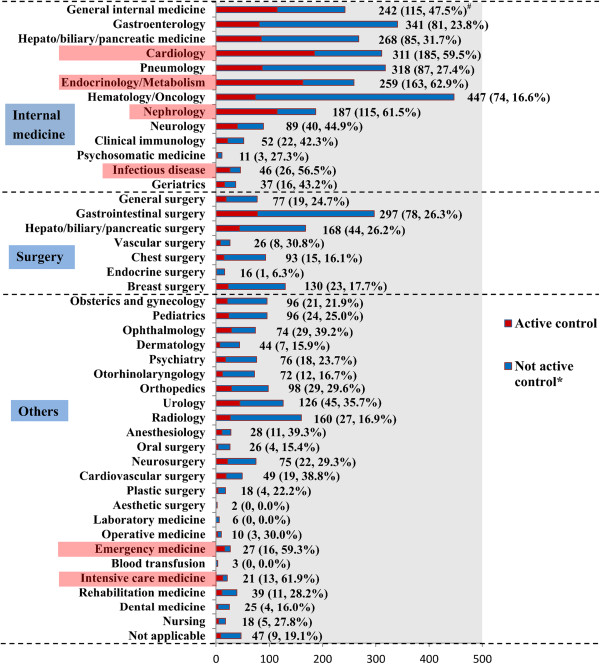
Disease-classified registration numbers by specialty and control type. The total number of registrations is 2,779. The registration numbers in different subcategories are not mutually exclusive. Six subcategories with a prevalence of <50% for using an active control are highlighted in pink. #All data labels: total number (number of active controls, percentage of active controls). *No active control: placebo, no treatment, dose comparison, historical, uncontrolled.